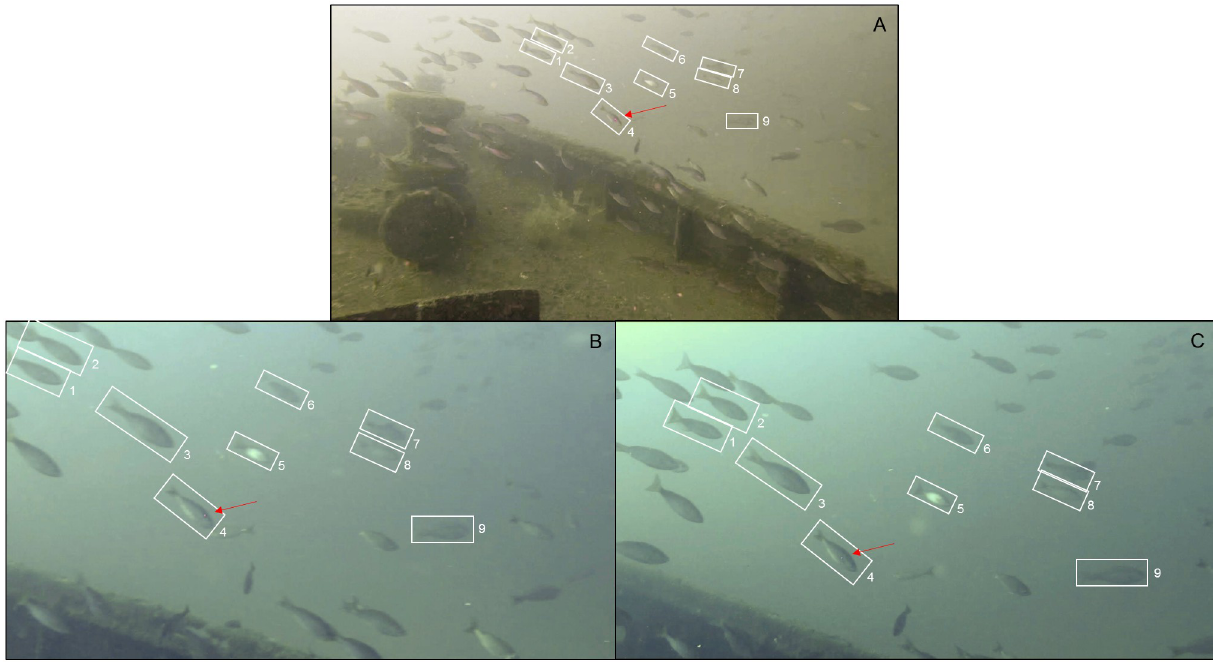
Fig 7. Example stereo camera vs red laser scaler sample availability. School of vermilion snapper passing in front of A) the center GoPro camera mounted atop the ROV, and the B) left and C) right stereo cameras during an artificial reef survey in the nGOM in 2018. Numbered white boxes indicate individuals whose lengths could be estimated with the SC system because they are entirely visible in both views simultaneously and are oriented � 25˚ from perpendicular to the ROV’s longitudinal axis based on their orientation in the horizontal plane in panel A. A single laser point is visible on individual 4 in all three images as indicated by the red arrow, which is insufficient to estimate length with the RLS.